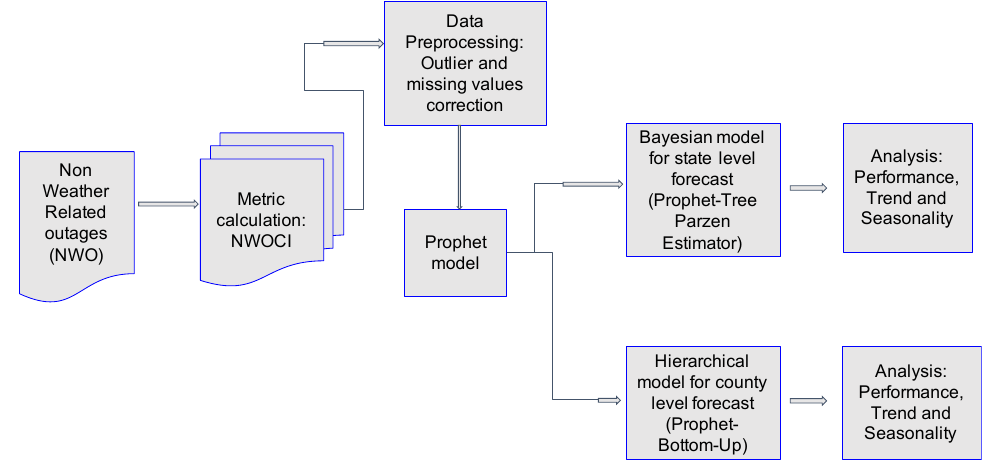
Figure 1. Flow chart of methodology used for this